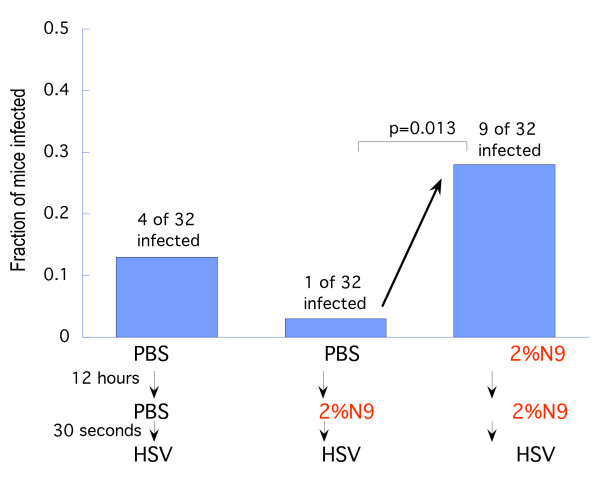
A single previous exposure to N9 can abolish the brief protective effect of N9. The low-dose inoculum (0.05 ID50) infected only a small fraction of the control group treated twice with PBS (first column), and an even smaller fraction was infected in the control group treated with 2% N9 just before delivering the inoculum (middle column). But a significantly larger fraction became infected in the test group (right-hand column), revealing that the N9 dose delivered 12-hour earlier abolished the protective effect of the N9 dose delivered just before the inoculum: P = 0.013 by Fisher's exact two-sided test.